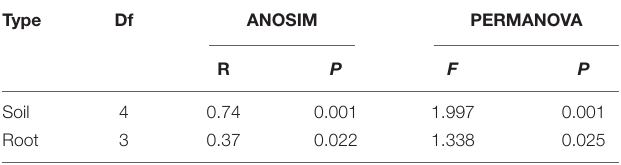
TABLE 4 | Analysis of similarities (ANOSIM) and permutation multivariate analysis of variance (PERMANOVA) showing differences in age groups in root-associated and rhizosphere soil AM fungal community compositions between different